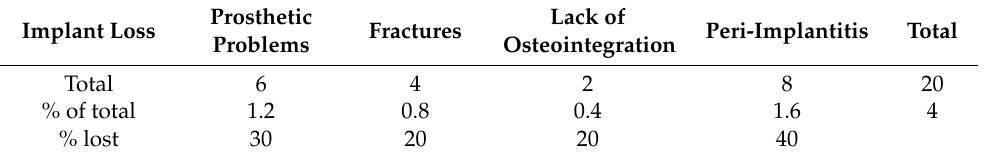
Table 2. Ti-Unite implants lost. Implant Loss